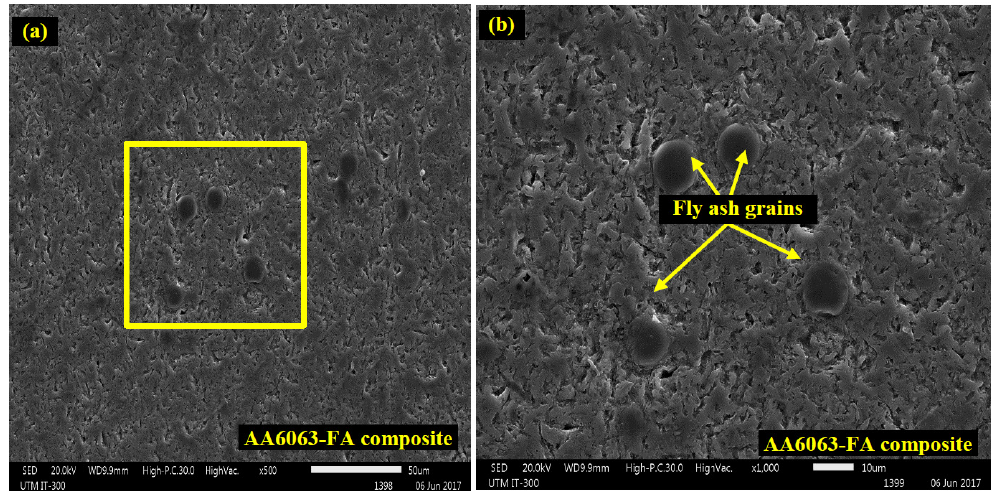
Figure 6. The microstructure of the AA6063-FA composite with 6 wt % fly ash observed under VP-SEM: ( a ) Fly ash grains in the surface at 500× and ( b ) 1000×.